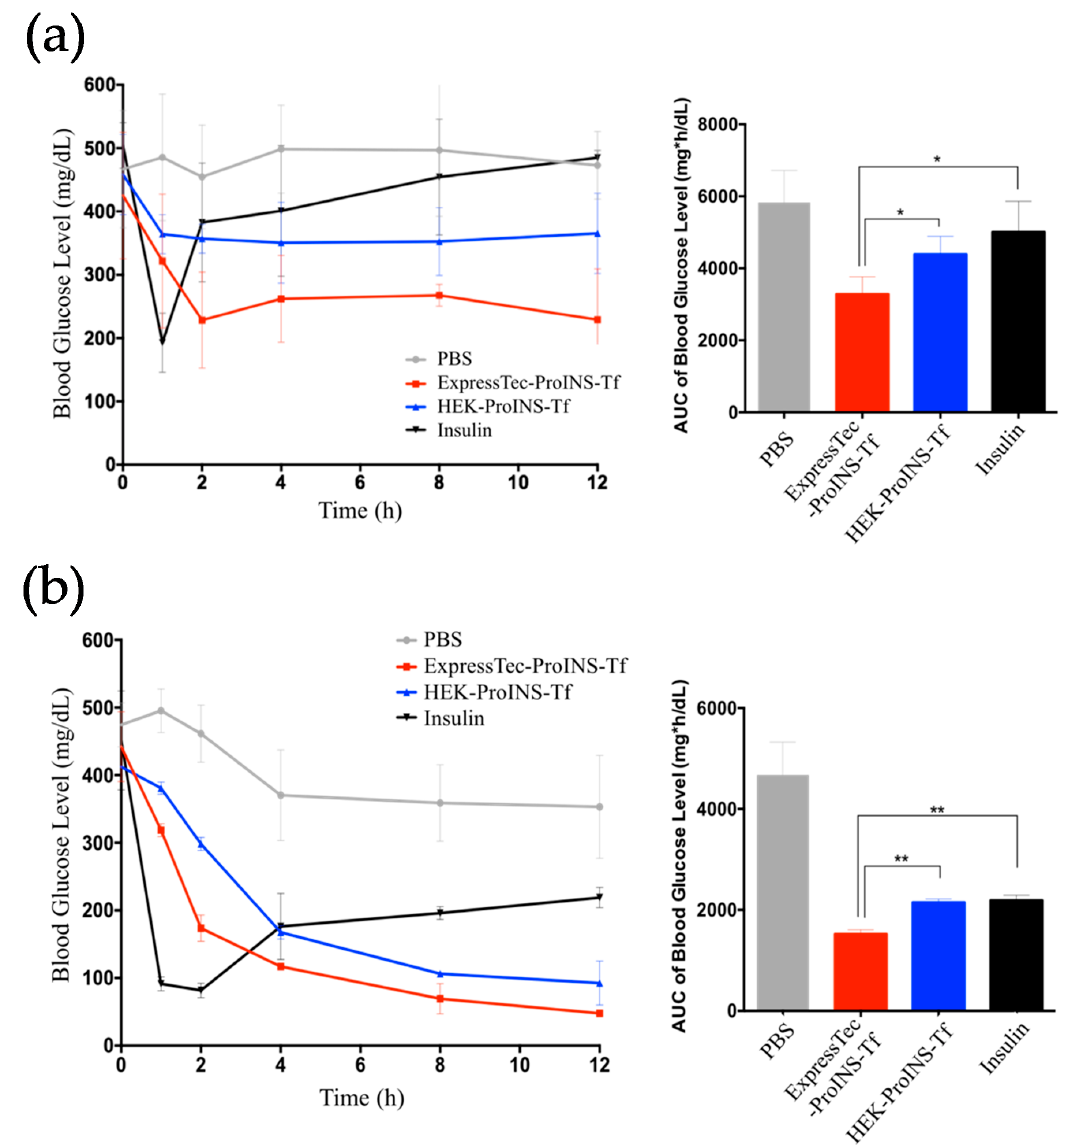
Figure 6. Glucose-lowering efficacy of ExpressTec-ProINS-Tf via subcutaneous injection. ( a ) STZ-induced type 1 diabetes mice under free-fed condition were subcutaneously injected with protein (22.5 nmol/kg) or PBS, and had free access to food and water during the experiment ( n ≥ 3 per group). Blood glucose levels were monitored at indicated time points. The AUC of blood glucose level (mean ± SD) from 0-h to 12-h time points in the right panel were calculated using GraphPad Prism (GraphPad Software Inc., San Diego, CA, USA). ( b ) STZ-induced type 1 diabetic mice were fasted for 2 h before the subcutaneous injection of protein or PBS ( n ≥ 3). Mice were kept fasted with free access to water until 12 h post injection. Blood glucose levels were monitored at the indicated time points. The AUC of blood glucose level (mean ± SD) from 0-h to 12-h time points in the right panel were calculated using GraphPad Prism (GraphPad Software Inc., San Diego, CA, USA). * p <0.05; ** p <0.01.